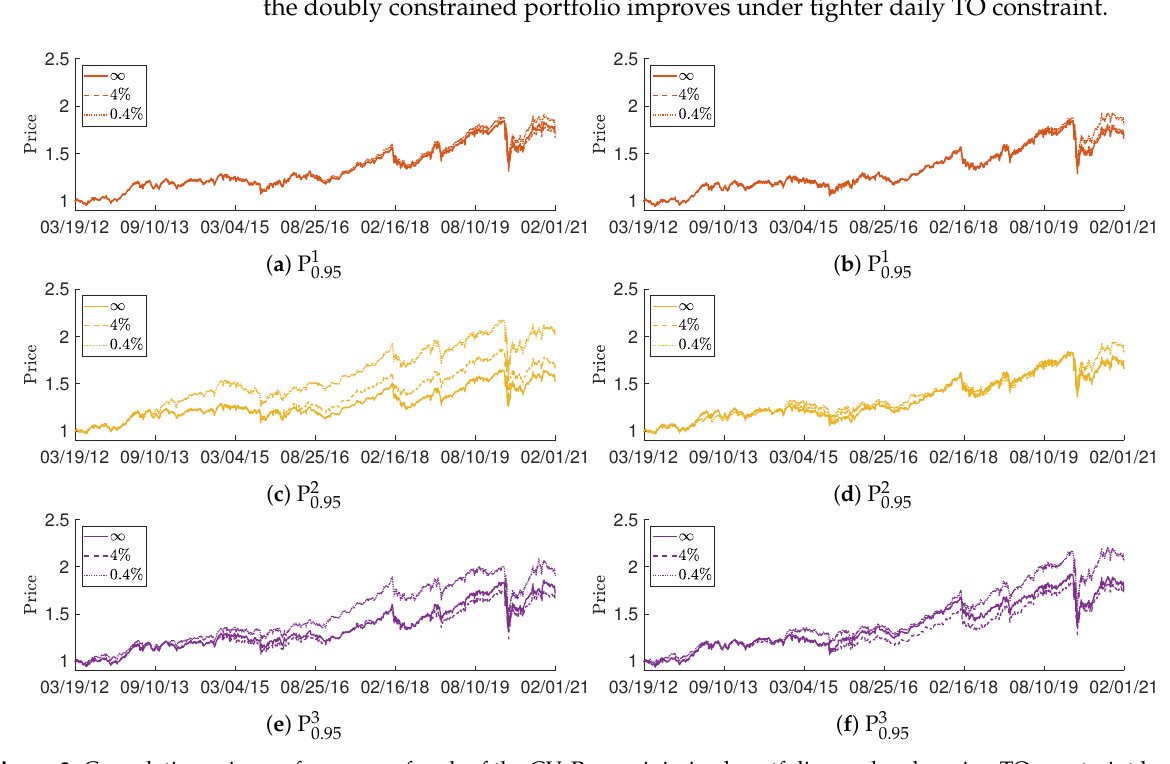
Figure 3. Cumulative price performance of each of the CVaR 0.95 minimized portfolios under changing TO constraint level; ( left ) equi-weighted benchmark, ( right ) price-weighted benchmark.